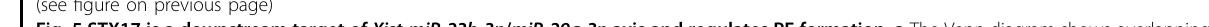
(Fig. 6G – I). In agreement with the previous studies showing that YY1 is implicated in autophagy in multiple cells 47,48 , we then con fi rmed that YY1 positively regulated the LC3B protein expression in the newborn ovaries (Supplementary Fig. S5A). As we showed that Xist pro-